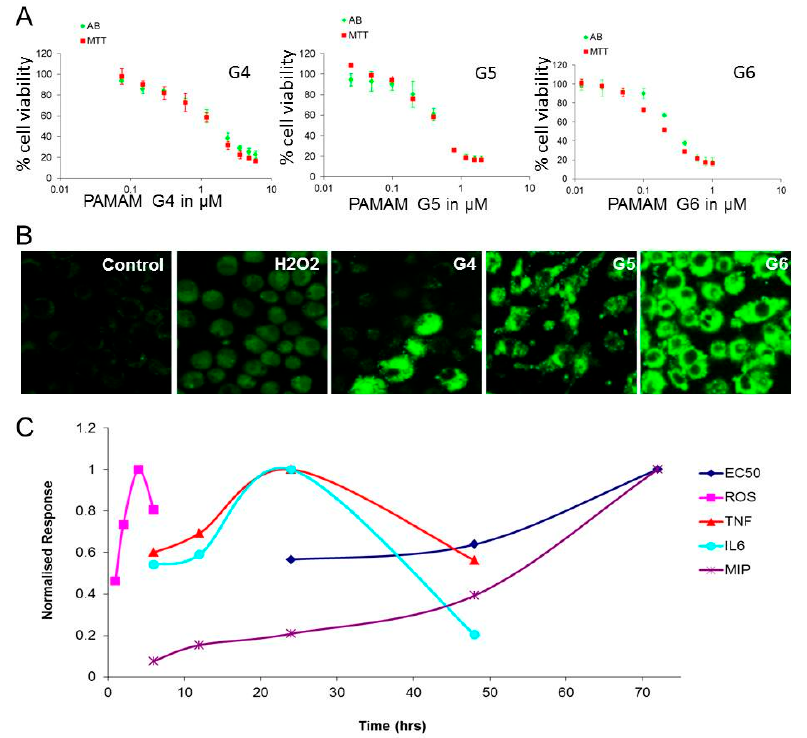
Figure 2. Panel ( A ), dose depend cytotoxicity effect of PAMAM dendrimer in J774A.1; cytotoxicity assay was performed via alamar blue (AB) and MTT assay. The concentration ranges used for the cytotoxicity assays with G4, G5, and G6 were 0.08 µ M to 6 µ M; 0.03 µ M to 2 µ M; and 0.013 µ M to 1 µ M micrographs of intracellular ROS generation in J774A.1 cells, following exposure to negative control, positive control (H 2 O 2 ), PAMAM G-4, PAMAM G-5, and PAMAM G-6. The data are shown after a 2 h exposure of PAMAM dendrimers. Panel ( C ), graphical representation of different responses as a function of time. Figure reproduced with permission from reference